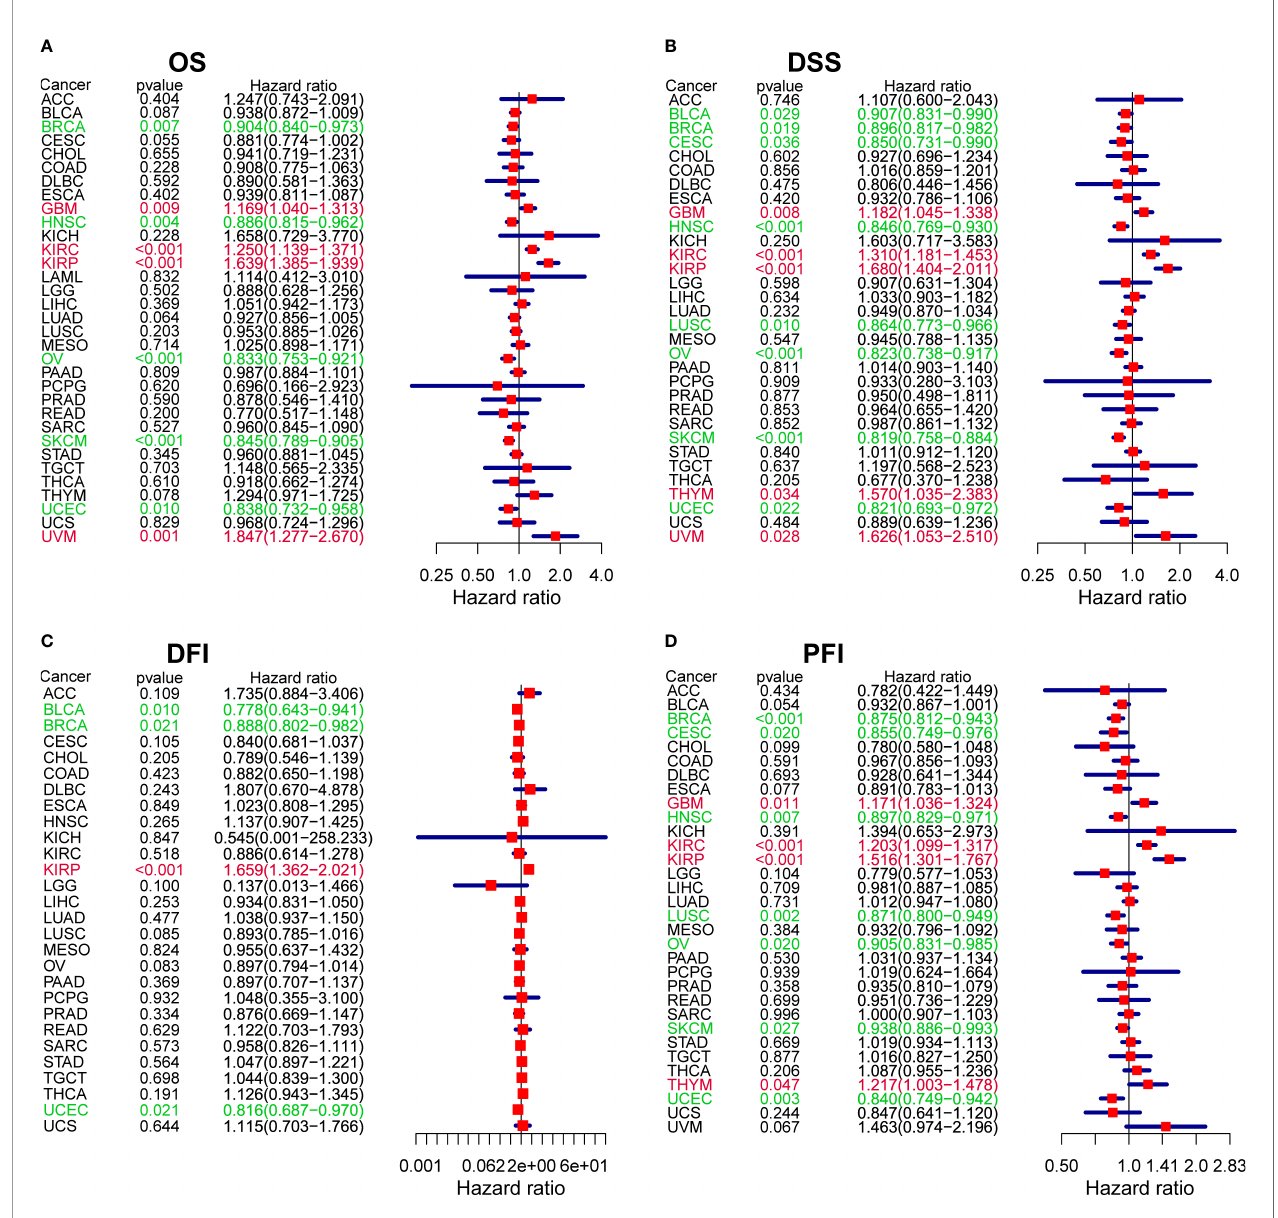
FIGURE 5 | The forest plots of univariate Cox regression analyses. (A) OS. (B) DSS. (C) DFI. (D) PFI. Red items indicate CXCL13 expression is a contributing factor to mortality. Green items indicate CXCL13 expression is a factor that inhibits